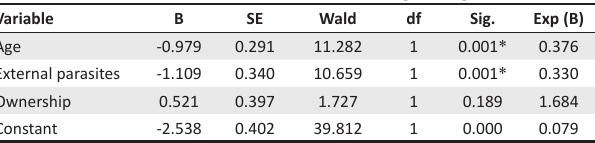
TABLE 1-A1: Variables in the binomial multivariable logistic regression